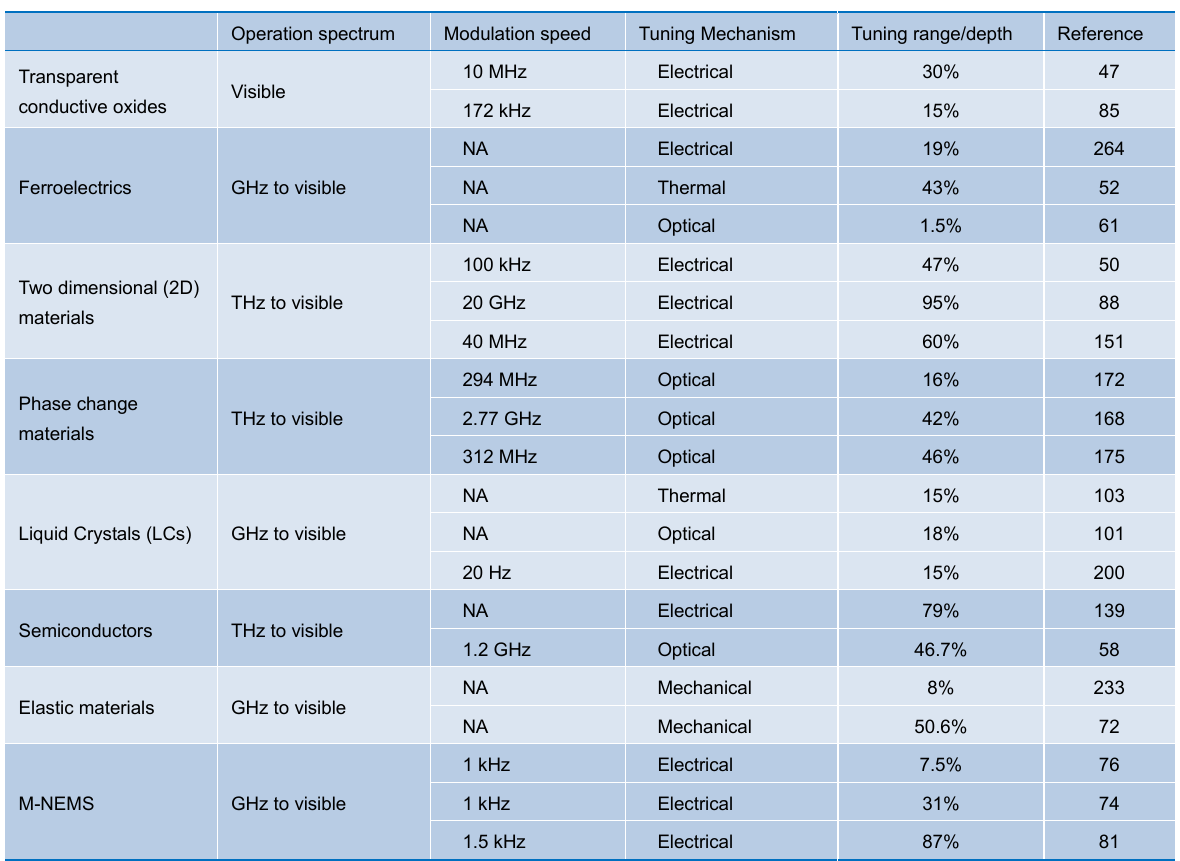
Table 1 | Comparison of different